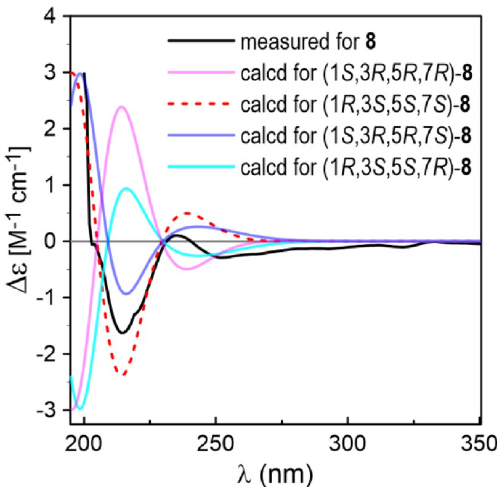
Fig. 5 Comparison of the measured ECD spectra of 6 and 7 with PBE0/TZVP/PCM(MeOH) calculated ECD spectra of (1 R ,3 S ,5 S )- and (1 S ,3 R ,5 R )- 6 (σ = 0.38, shift = −11 nm)